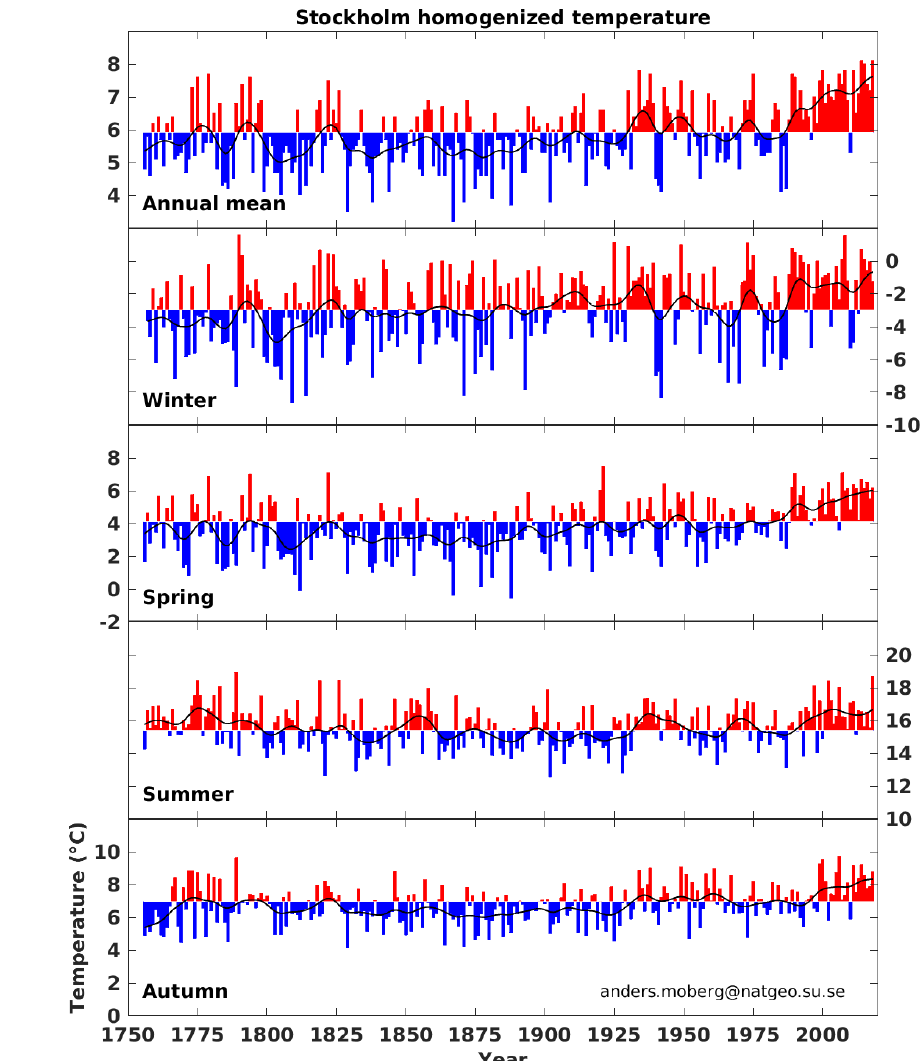
Figure 8. Homogenised annual and seasonal mean temperature in Stockholm during 1756–2018. Each coloured bar shows the annual mean temperature, in red or blue, depending on whether the temperature is above or below the average during the reference period 1961–1990. The black curve represents smoothed 10-year mean temperatures. Source: https://bolin.su.se/data/stockholm-historical-temps-monthly (last access: 17 February 2022); Anders Moberg, Stockholm University,